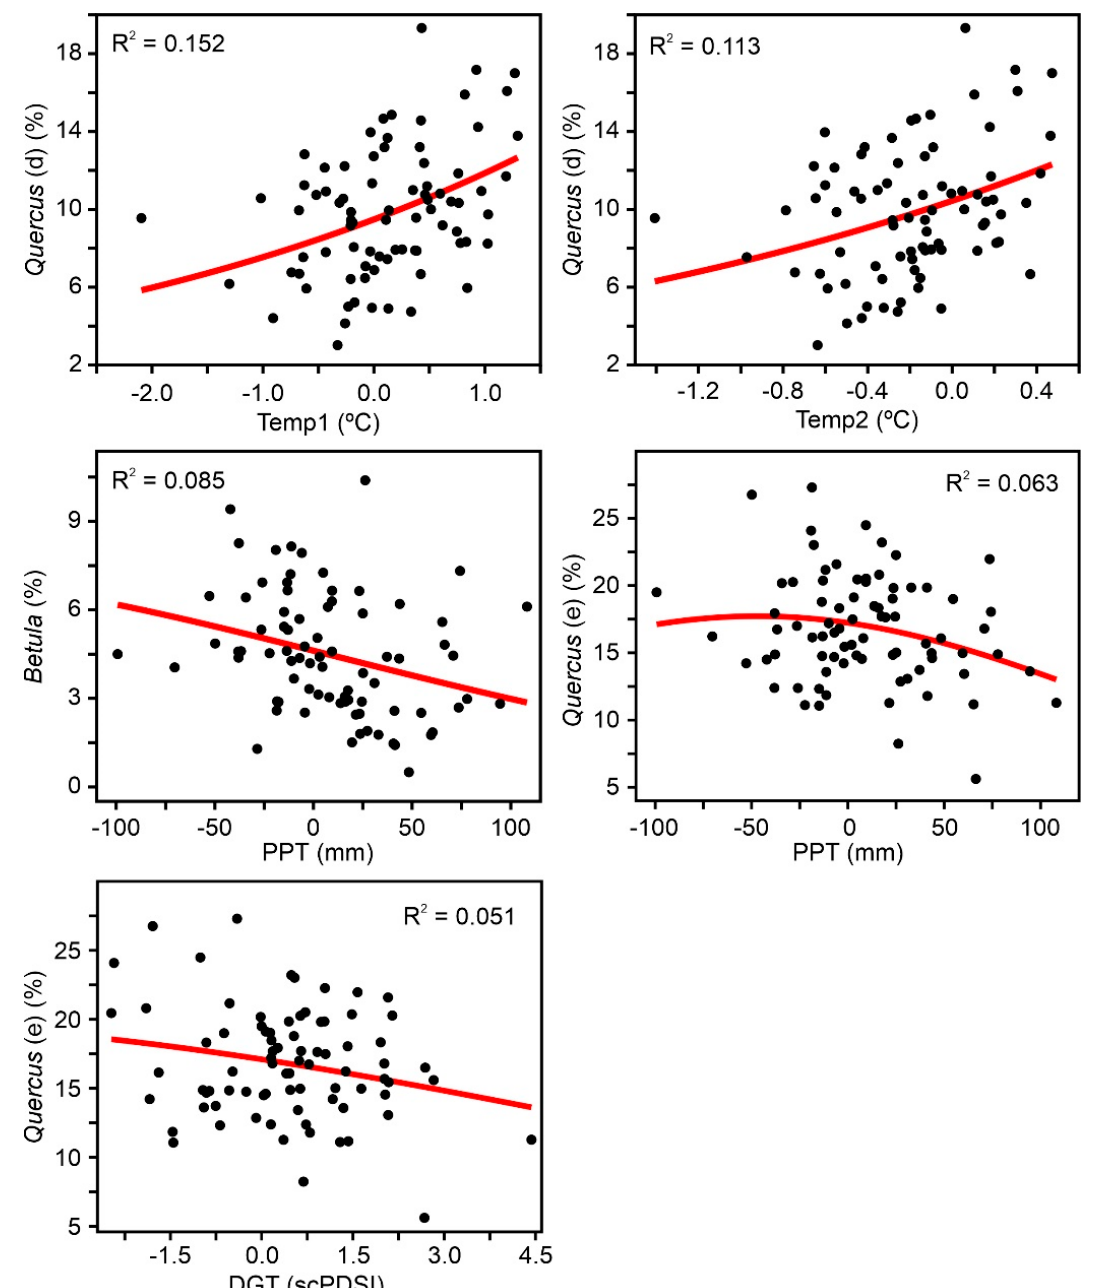
Figure 8. Forest taxa with significant Gaussian responses to climatic reconstructions.